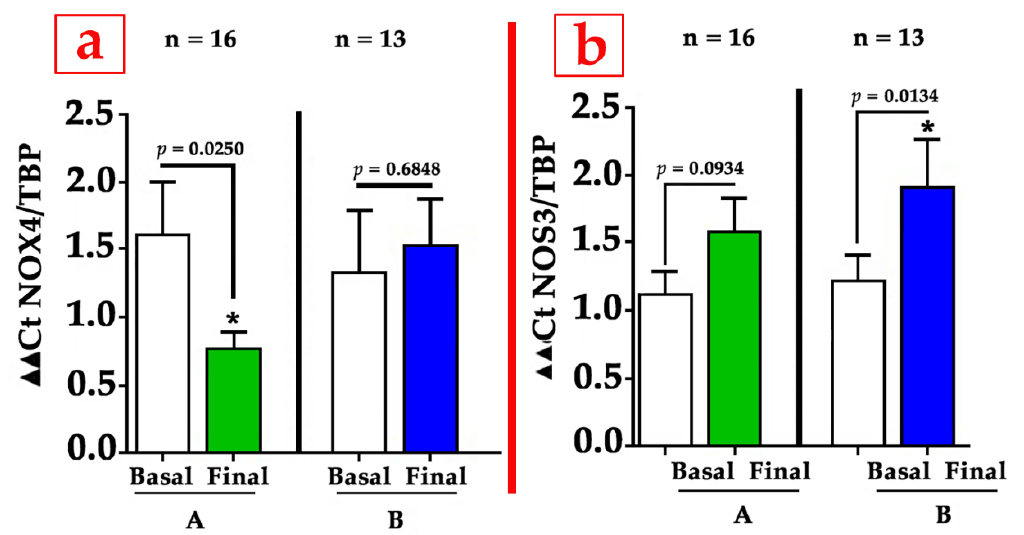
Figure 5. GH decreases the redox stress in ischemic muscles from the calf of patients with critical limb ischemia. Insights from the GHAS trial. ( a ) : shows the significant decrease in NOX4 mRNA levels only seen in the GH-treated group ( A, green bars) and not in Placebo-treated group ( B, blue bars). ( b ): depicts the significant increase in the levels of NOS3 (eNOS) mRNA during the period of treatment in patients with placebo related to its baseline levels, while in the GH group ( A ), although there was also an increase in NOS3 mRNA levels after the treatment, this increase was not significant. Samples from soleus muscle. Group A: GH; Group B: placebo. Basal: baseline mRNA levels before treatment; final: final mRNA levels after 8 weeks of treatment. Statistics: non-parametric test. Note that of the 36 patients initially recruited for the study, complete muscle samples (basal and final) were only obtained from 28 of them as a result of deaths, limb amputations, or the patient´s refusal to allow for the second biopsy. * indicates statistically